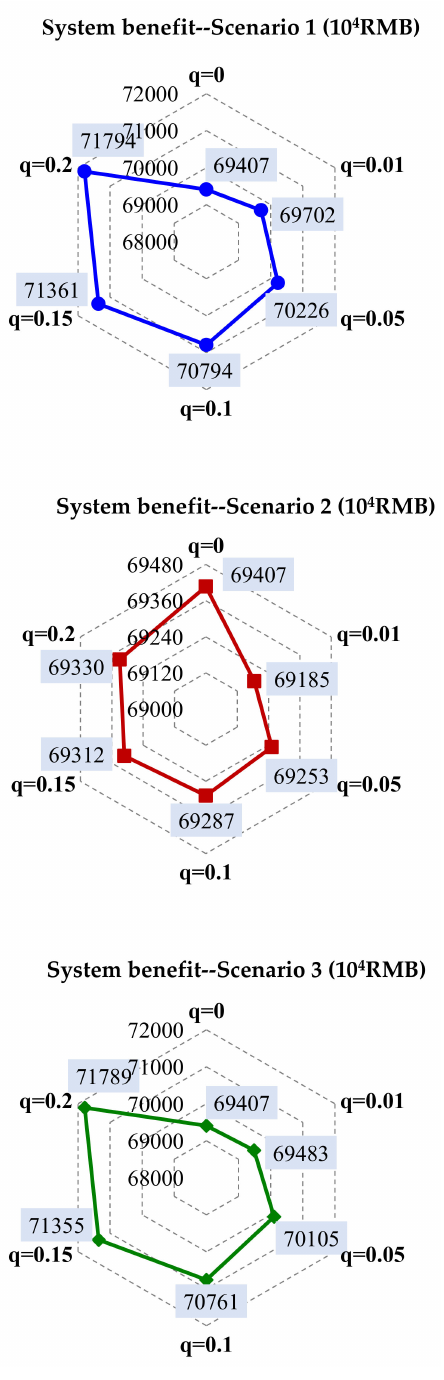
Figure 6. System benefit under different